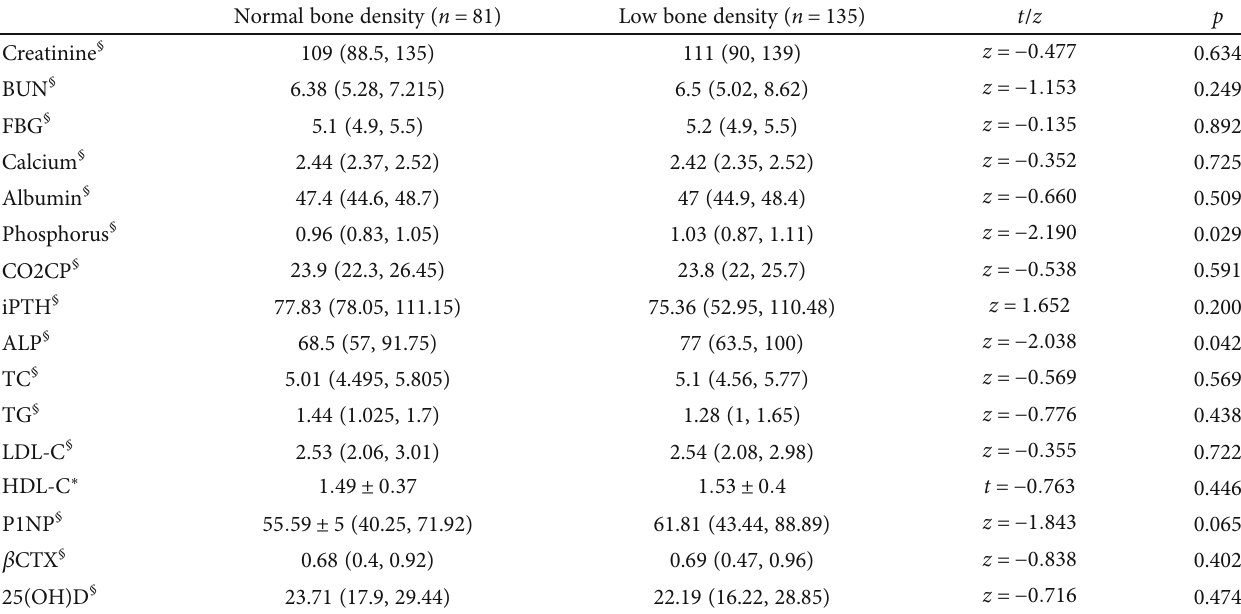
Table 2: The baseline biochemical characteristics of the patients.